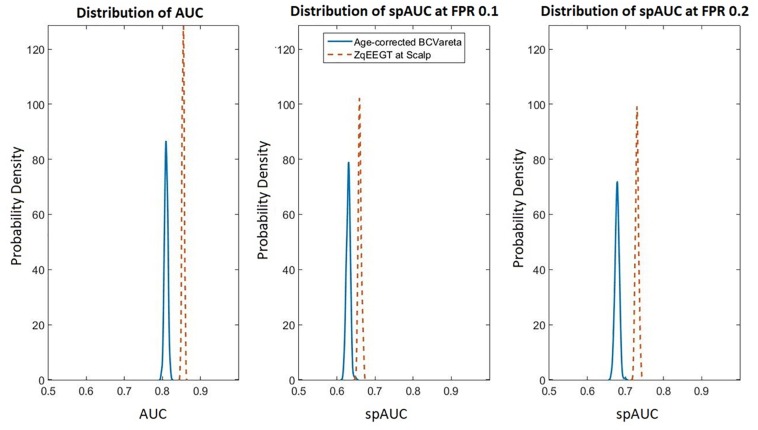
Comparison of scalp based and source-based BC-VARETA classification accuracy. As in Figure 1, the probability density functions of the AUC are shown for the full curve (left), the spAUC at 0.1 (center), and at 0.2 (right) false positive probability cut-off points. The blue (solid) lines correspond to the age-adjusted BC-VARETA classifier, while the red (dashed) lines correspond to the scalp qEEG based classifier. The scalp-based classification performed slightly better than the classifiers at the sources.